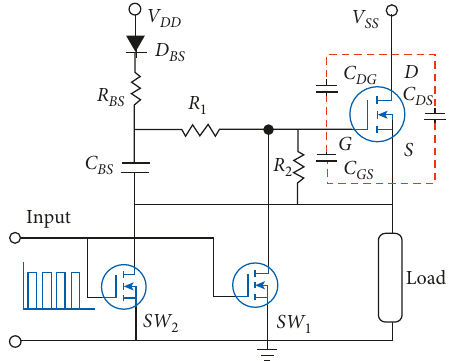
Figure 2: Bootstrap circuit for high-side